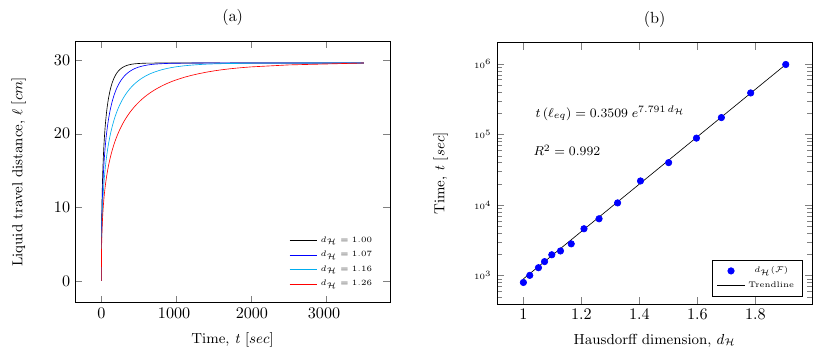
Figure 4. Time equilibrium distance as a function of Hausdorff dimension of capillar for a generic von Koch curve with the indentation angle 0 ◦ ≤ γ ≤ 90 ◦ . ( a ) Imbibition time vs imbibition Height or straight-line distance of fluid penetration. ( b ) Hausdorff dimension vs imbibition time for 1 ≤ d H ≤